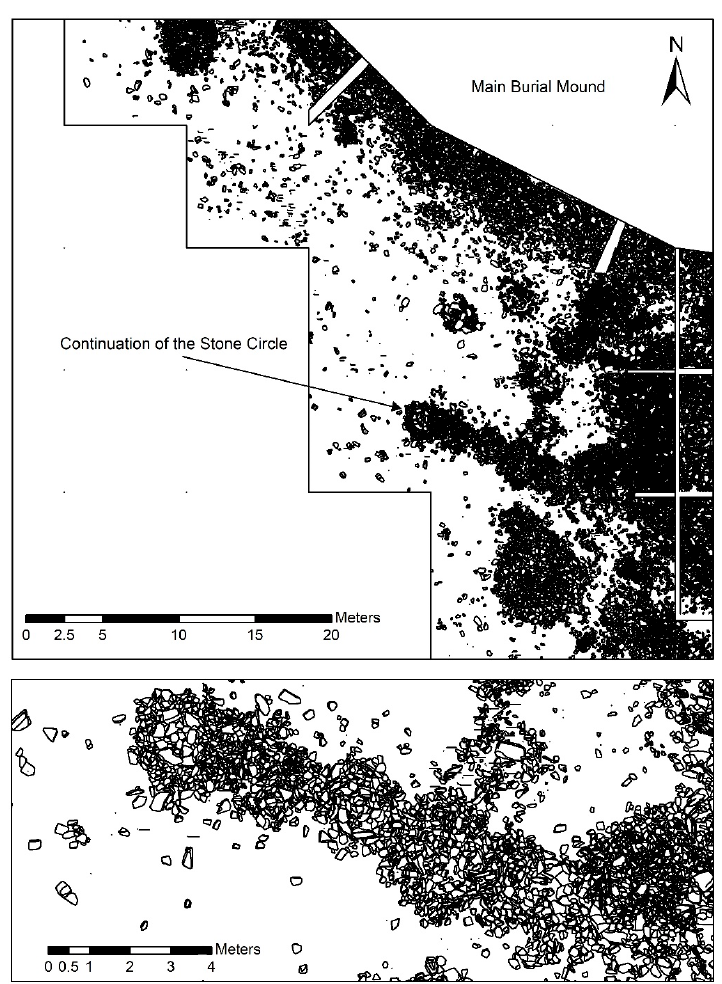
Figure 7. ( top ) Excerpt of the 2018 excavation report showing the documented stone structures underneath an only 20 cm deep topsoil layer in the southern periphery of the burial mound. ( bottom ) Close-up of a line of circular shaped stone mounds of ~2 m in diameter lined up in approximate east–west